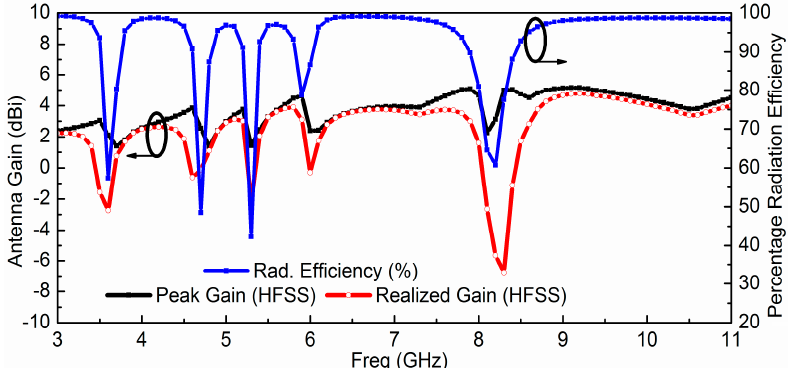
Figure 5. Simulated antenna gain from the radiator, percentage radiation efficiency, and realized antenna gain including the effects of the input mismatch of the quintuple band-notched UWB antenna.